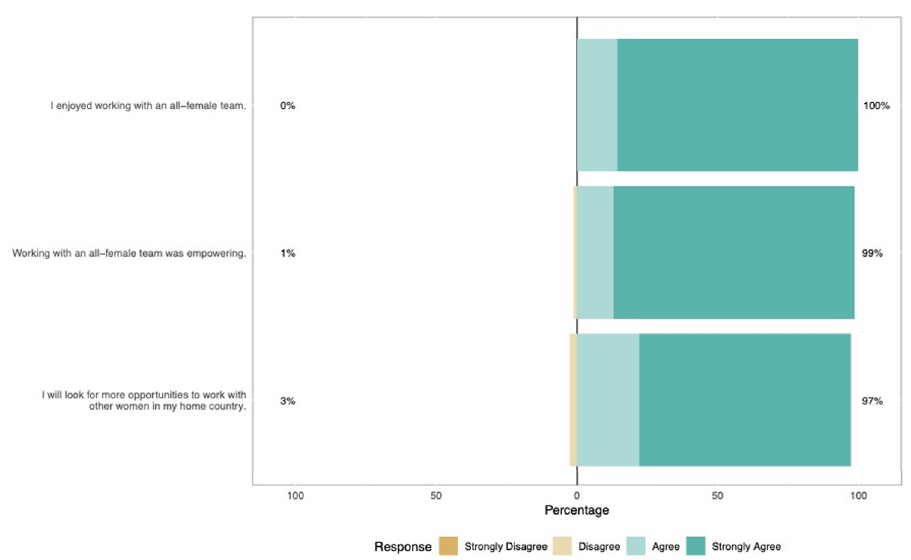
Fig 6. Opinions on working with other women after the women’s